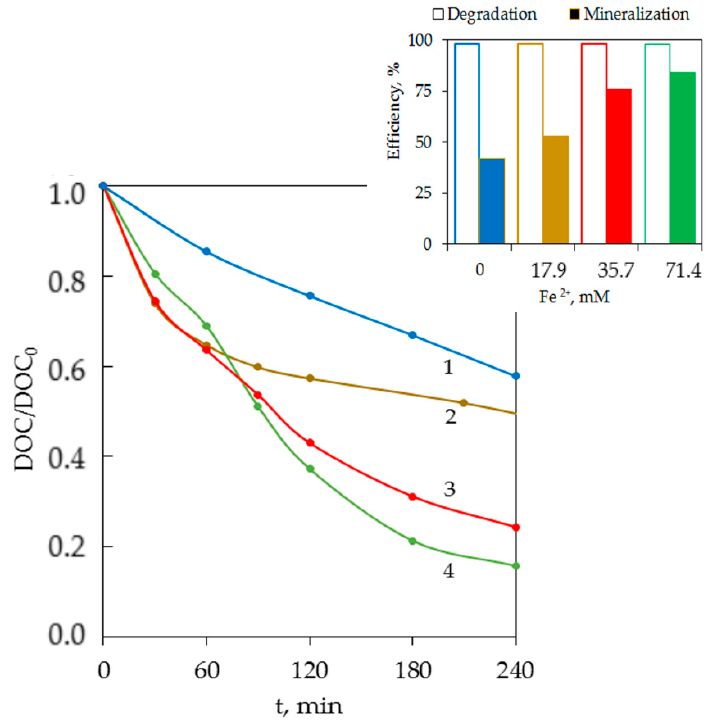
Figure 4. Influence of Fe 2+ concentration on DOC mineralization in the UV/Fe 2+ /S 2 O 8 2 − system: [BPA] 0 = 43.8 µ M, [S 2 O 8 2 − ]:[BPA] = 5:1. Fe 2+ concentration ( µ M): 0 (curve 1), 17.9 (curve 2), 35.7 (curve 3), 71.4 (curve 4). The inset shows BPA degradation (t = 20 min) and DOC mineralization (t = 240 min) as a function of the Fe 2+ concentration.